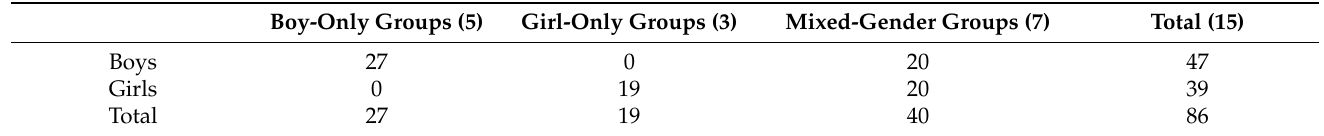
Table 1. The distribution of boys and girls in groups.